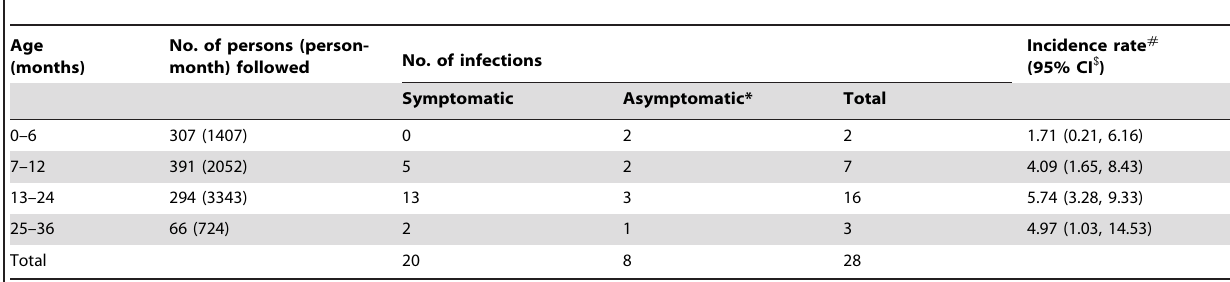
Table 2. Age-specific incidence rates of enterovirus 71 infection in northern Taiwan, 2008–09.